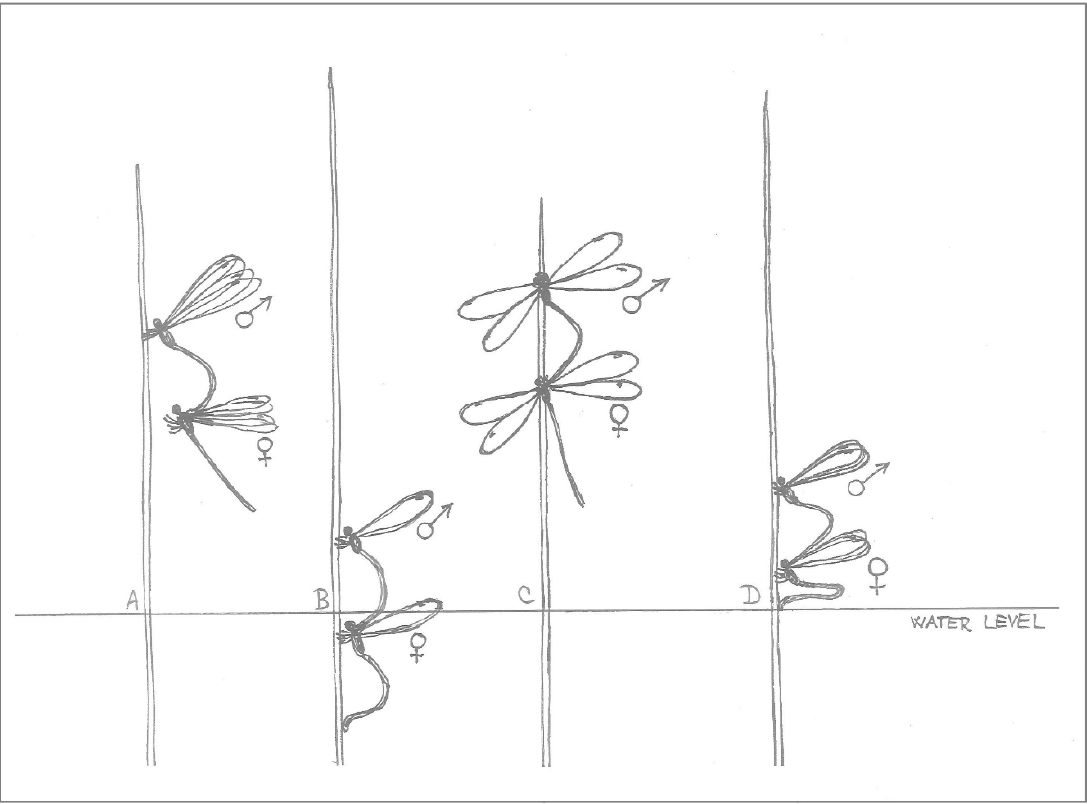
Figure 1. ( A ) Tandem of Lestes sponsa landing on the plant stem, male first; ( B ) ovipositing tandem with the female almost under the water; ( C ) the tandem drying their wings after final oviposition on the plant; ( D ) the female shaping her abdomen to refuse submersion.